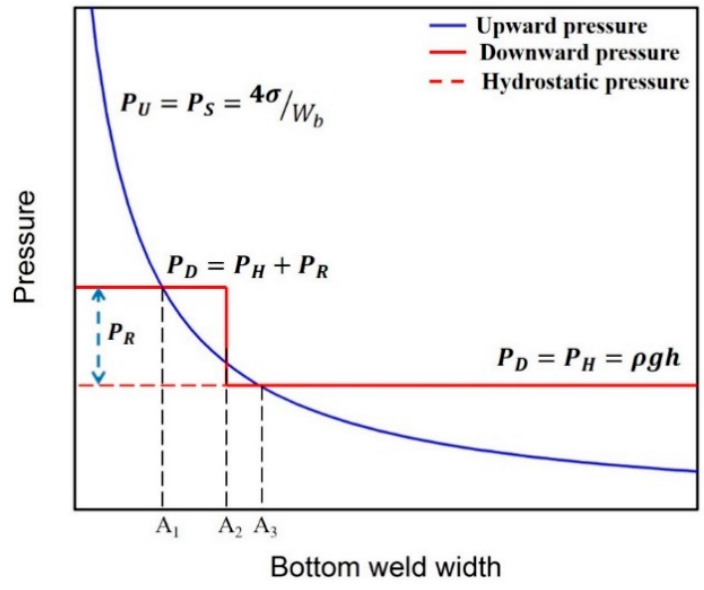
Figure 9. The pressure balance relationship at various weld geometries.